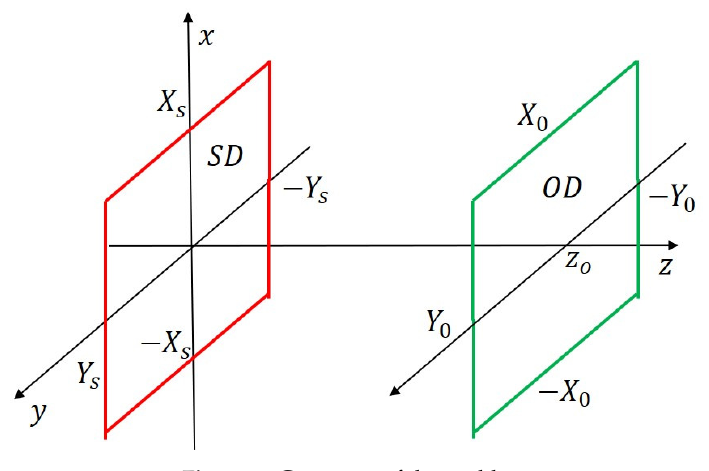
Figure 1. Geometry of the